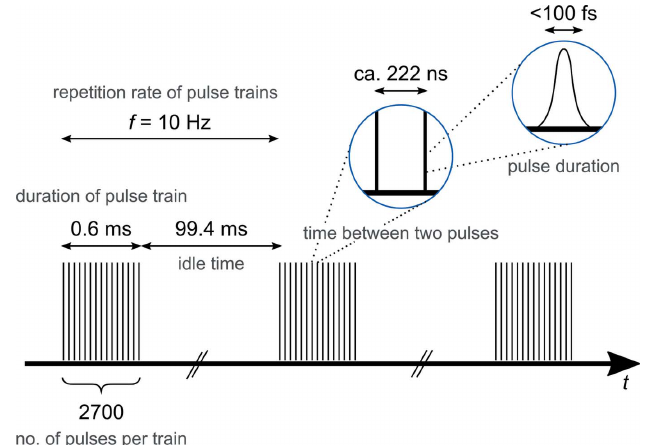
Figure 1 The high repetition rate X-ray pulse pattern at the EuXFEL. X-ray pulses arrive in 10 Hz trains at the sample and each train can provide up to 2700 ultrashort